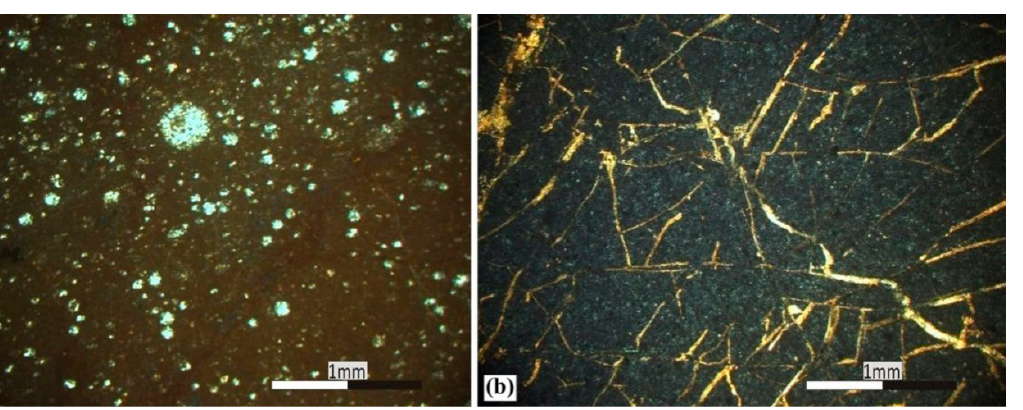
Figure 22. Representative photomicrographs of limestones. ( a ): Micritic texture of LS1 sample, in cross polarized light (XPL). Note topically microcracking with black color; ( b ): Veins with different sizes and orientation filled by sparitic carbonates in a micritic microstructure of LS2 sample (XPL); ( c , d ): Sparitic to microsparite mainly texture of LS3 sample. Oxides/hydroxides (brown to red colors) impregnated the microstructure, especially along to the microcrackings or pores (black color). Presence in low amounts of siliceous material in micro areas with low birefringence (first order white-grey polarized colors) (XPL).